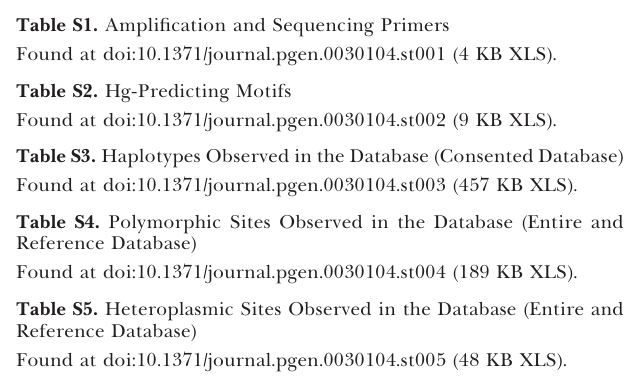
Table S1. Amplification and Sequencing Primers Table S2. Hg-Predicting Motifs Table S3. Haplotypes Observed in the Database (Consented Database) Table S4. Polymorphic Sites Observed in the Database (Entire and Reference Database) Table S5. Heteroplasmic Sites Observed in the Database (Entire and Reference Database) Table S6. Classic HVS-I Motif Homoplasy (Reference Database) Table S7. Haplotypes Homoplasy (Consented Database, 22-SNP Group) Table S8. Classic HVS-I Haplotypes Back Mutation Events (Reference Database) Table S9. Coding-region SNPs Homoplasy (Reference Database) Table S10. Hg Prediction by Classic HVS-I Rules and NN Using Variable Sets of Coding-Region SNPs (Entire Database) Table S11. Divergent Measures of Neanderthals (Entire